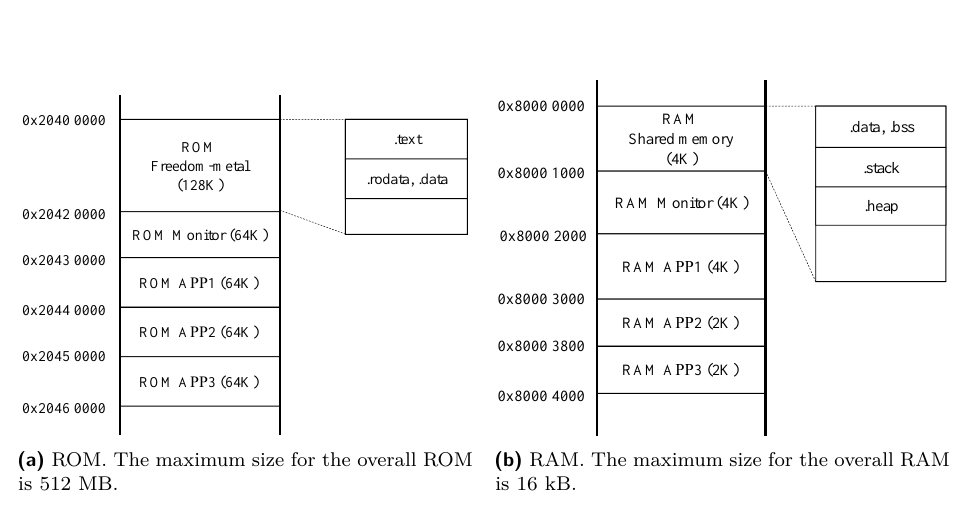
Figure 15: Memory